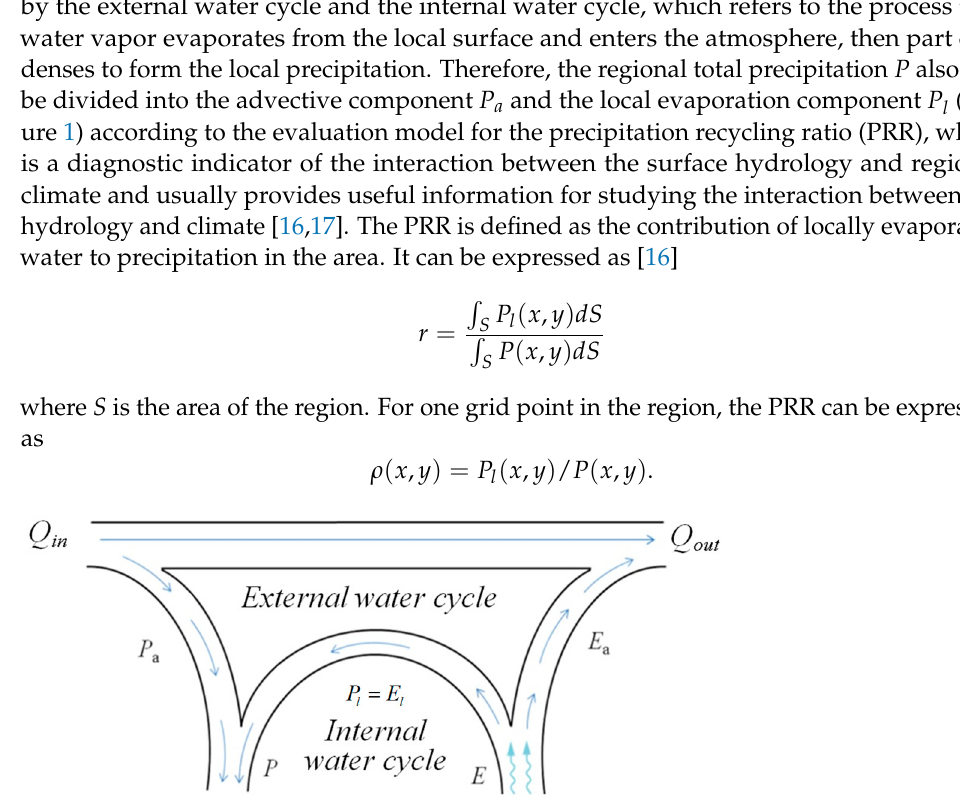
Figure 1. Schematic diagram of atmospheric moisture recycling in a region, consisting of the internal water cycle and external water cycle. E is the evaporation from the region, and E l is the component of E that becomes the local precipitation P l through the internal moisture cycle. Q in is the total water vapor input into the region, and Q out is the total water vapor output.